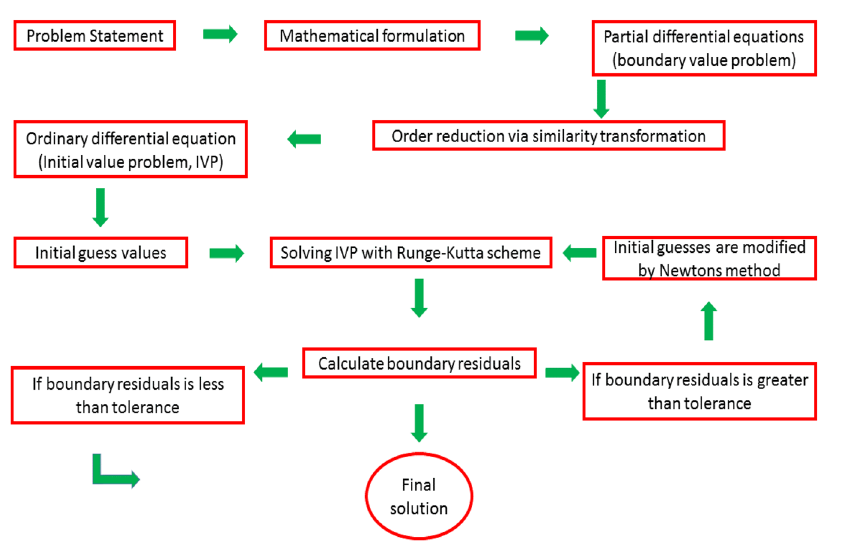
Figure 2. Schematic diagram of numerical scheme.